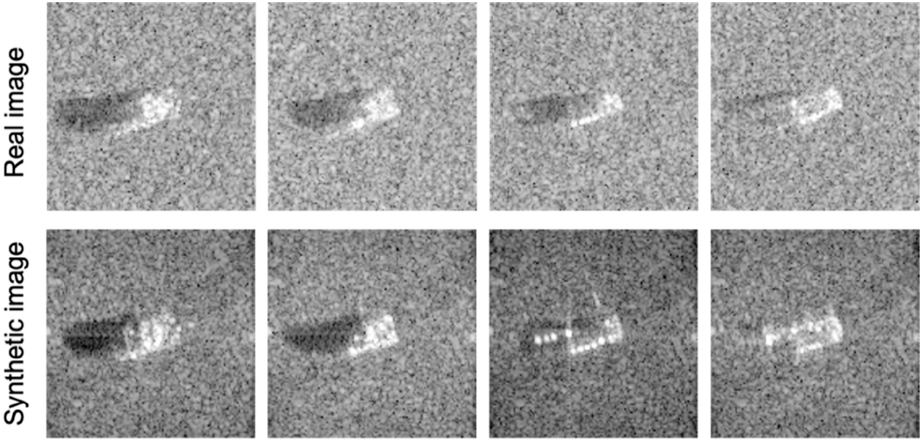
Figure 1. Examples of real and synthetic SAR images in SAMPLE, demonstrating substantial target differences located in the middle of the images.